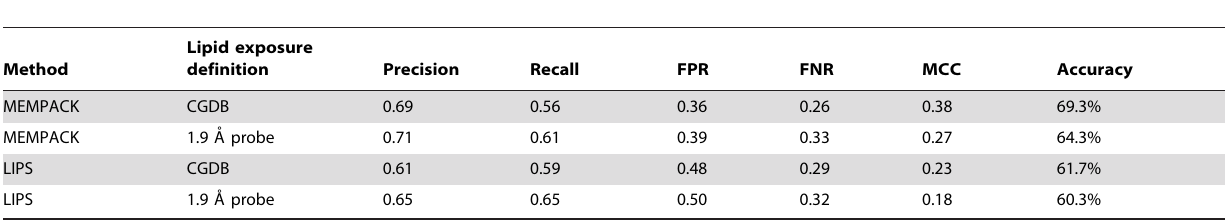
Table 1. Per residue lipid exposure prediction performance using a data set of 77 sequences.